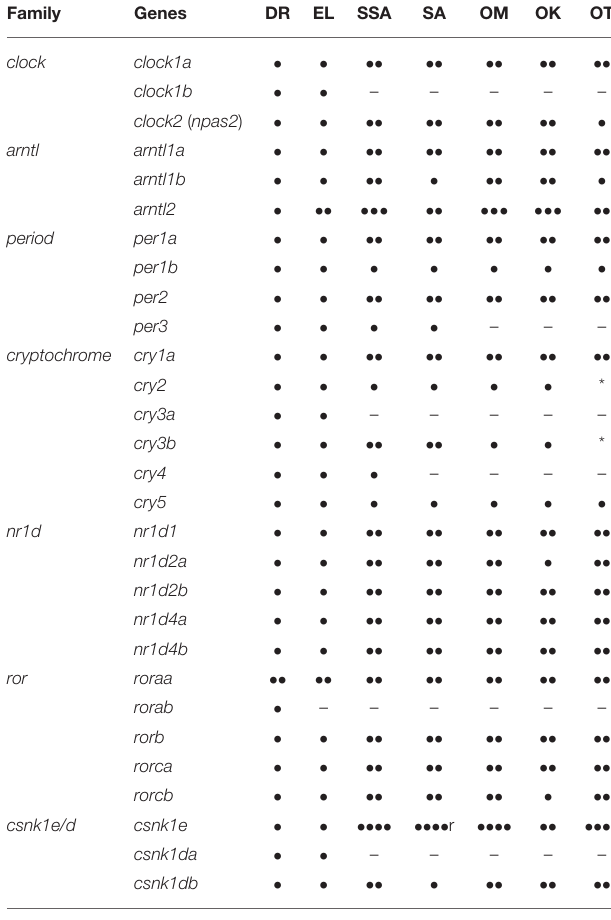
TABLE 1 | Genomic structure of the gene families associated with the circadian clock of